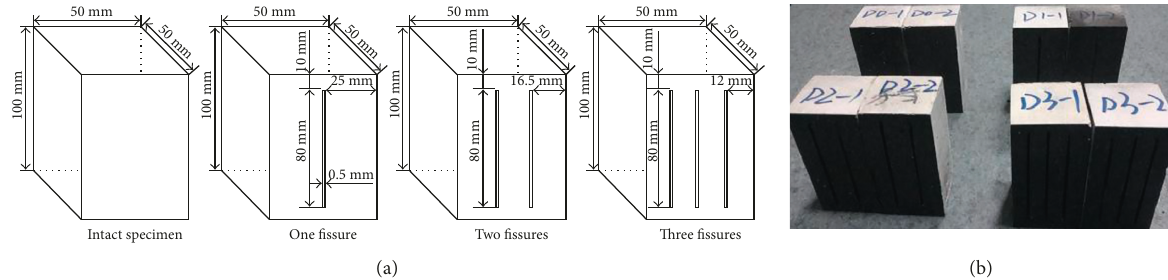
Figure 2: Sketch of test specimens. (a) Sketch of layer-crack rock models and (b) part of the test specimens.